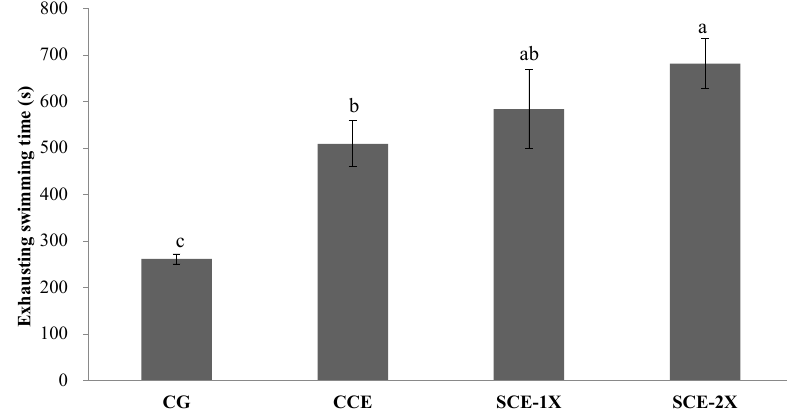
Figure 1. The effect of different treatments on exhausting swimming time in mice. Values are means±standard deviation for n = 8 mice per group. CG, control group; CCE, commercial dripped chicken essence; SCE-1X, spent hen dripped chicken essence; SCE-2X, double dosage of spent hen dripped chicken essence. a-c Bars with different letters are significantly different at p<0.05.